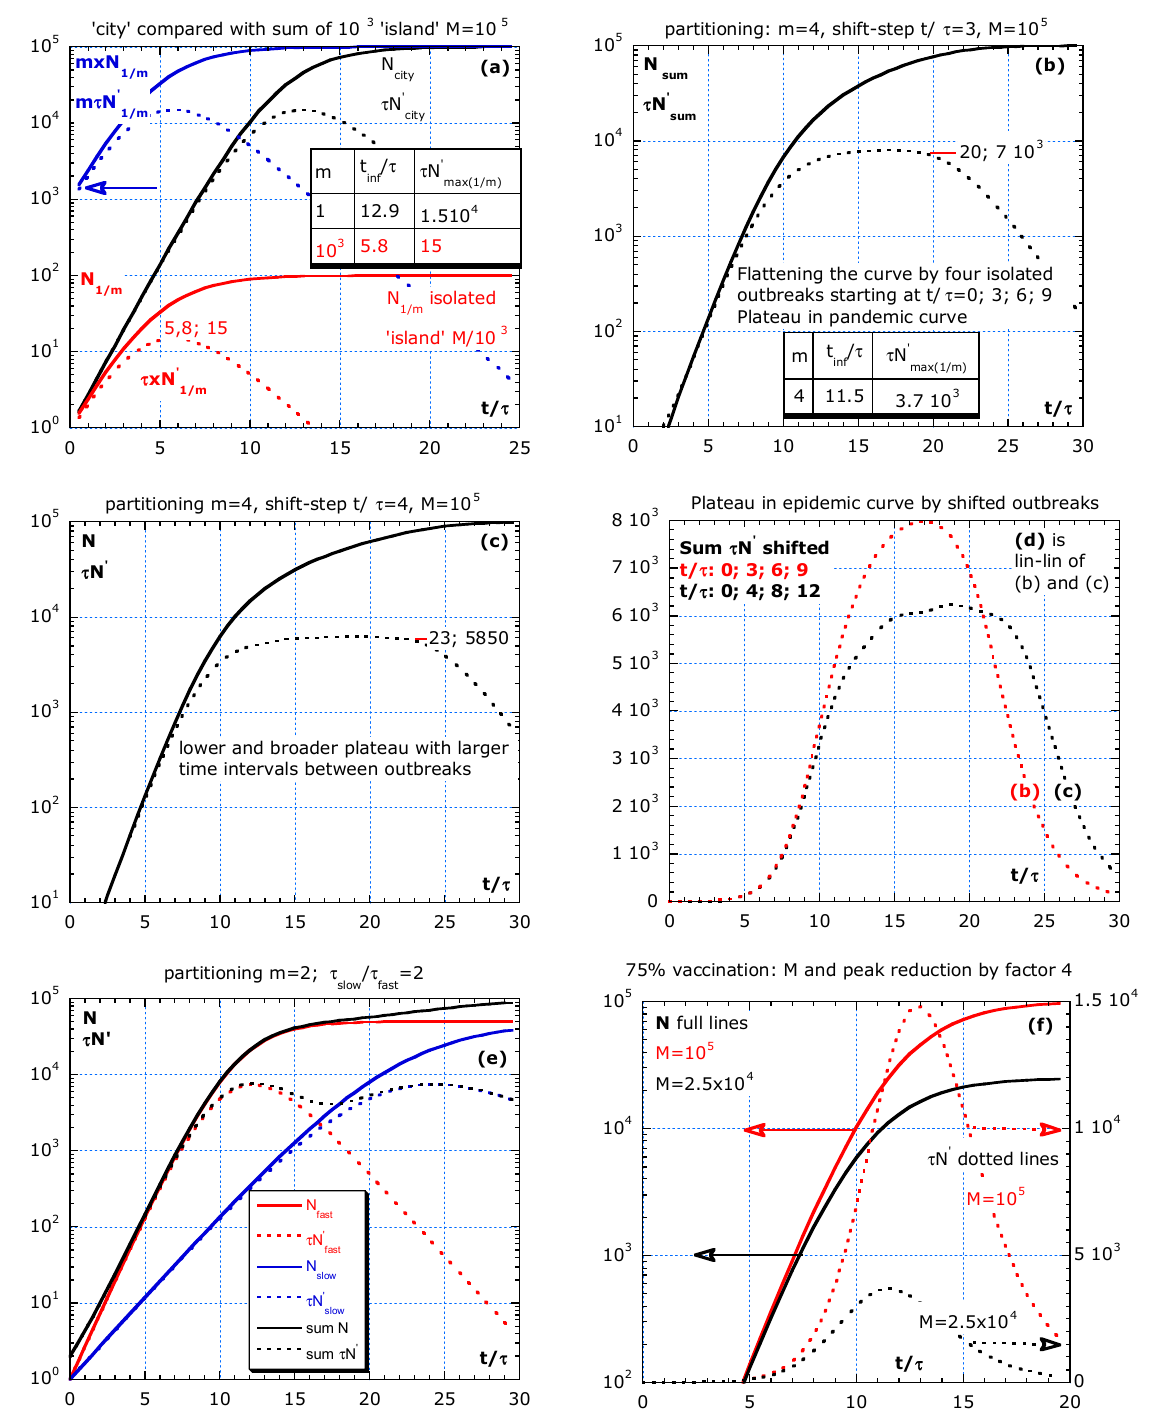
. N ≡ τ N (cid:48) . ( a ) A . N and one